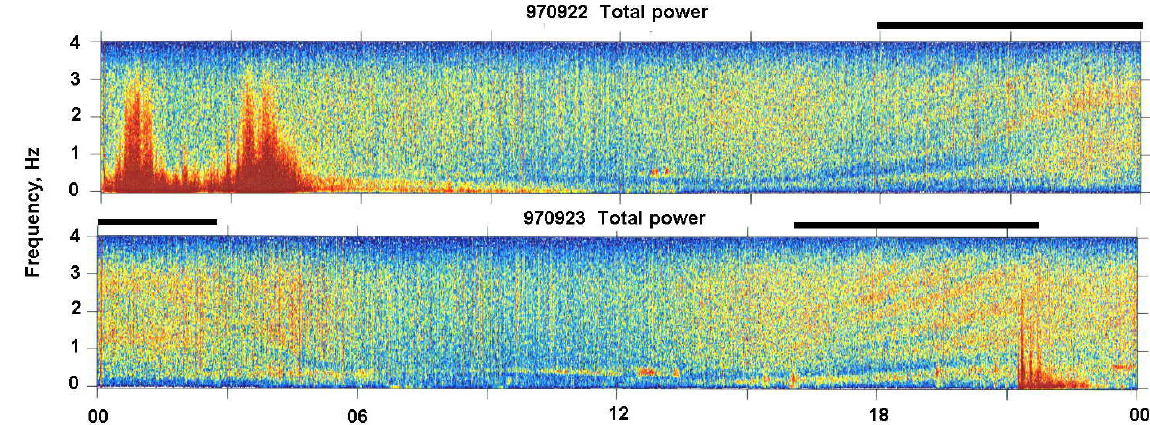
Fig. 1. Examples of the Spectral Resonance Structure observed at Geophysical Observatory Sodankyl¨a (SGO). Spectrograms for two suc- cessive days are shown. Intervals of visible SRS are marked by black bars above the spectrograms.